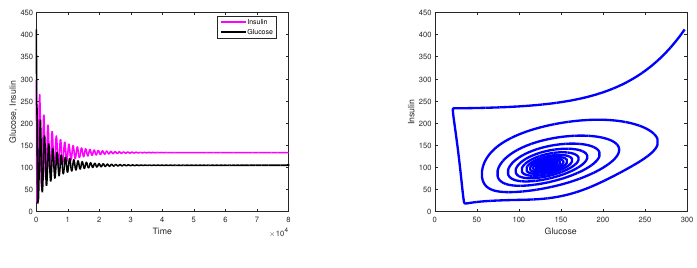
Figure 7. Glucose-insulin dynamics: dynamics and phase plain for τ = 200 < τ • = 228 min.